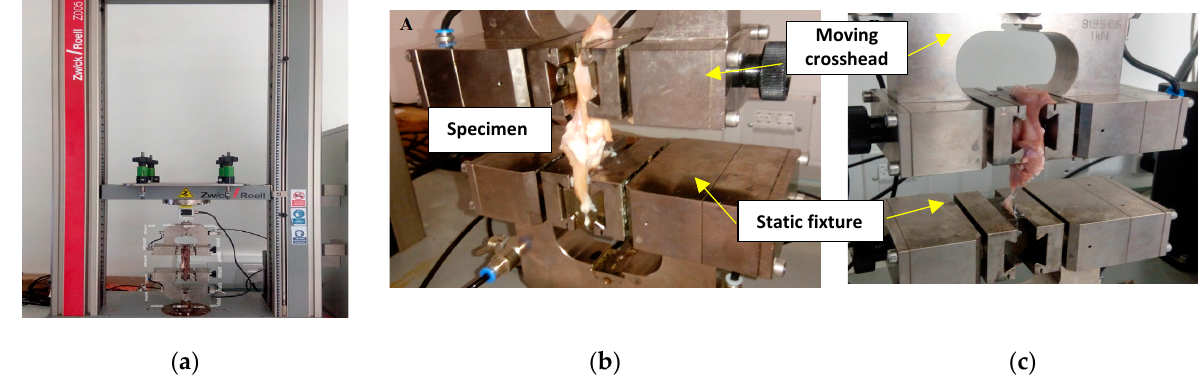
Figure 5. Tensile testing of fossa ovalis: ( a ) apparatus setup, ( b ) preload, and ( c ) rupture.